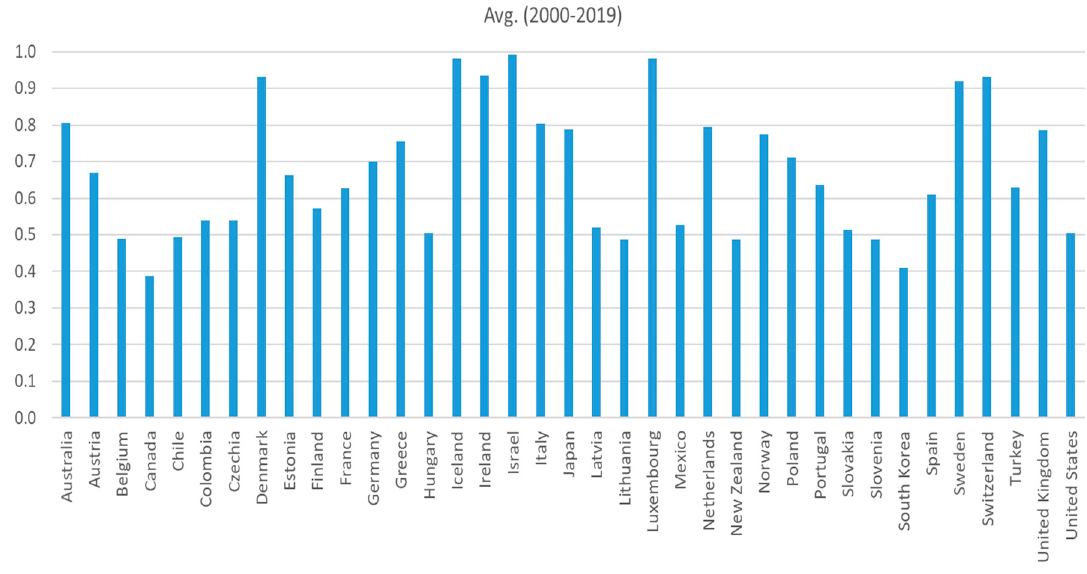
Figure 4 . Average efficiency ( CSOE ) of OECD nations (2000–2019). Note: This figure was prepared by the authors.